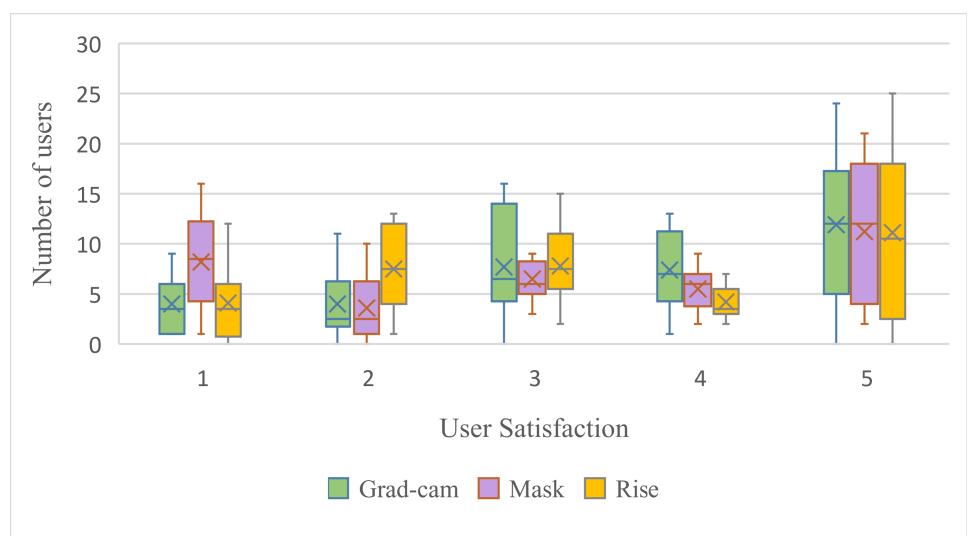
Figure 20. The user satisfaction distribution of different interpretation algorithms. Each interpretation method is tested with 10 images from DataM and 35 users. Satisfaction score is 1–5 (1 means most dissatisfied, 5 means most satisfied).